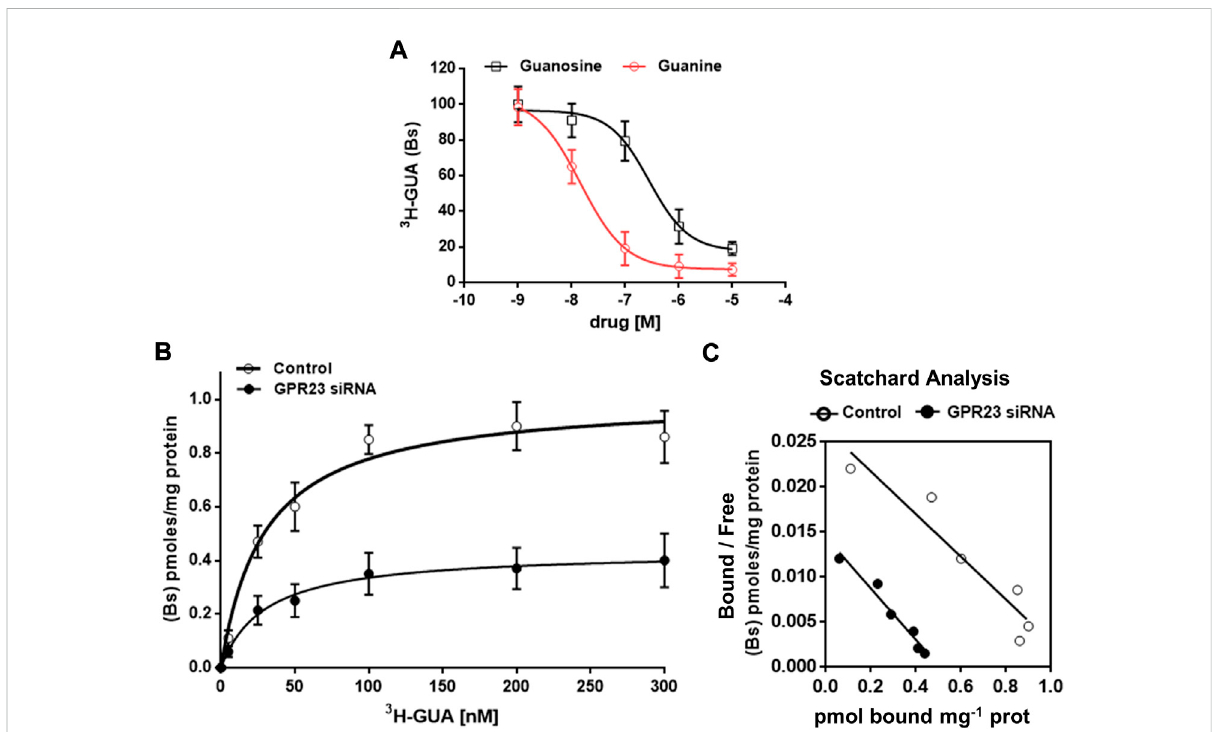
FIGURE 6 Characterization of [ 3 H]-GUA radioligand binding to U87 cells membrane extracts. In all experiments membrane extracts were incubated with the indicated drugs under standard assay conditions, i.e., 30 min incubation time, 25 ° C temperature, pH 7.4). (A) Displacement of 50 nM [ 3 H]-GUA binding from U87 cell membrane (50 μ g protein) by unlabeled GUA or guanosine (GUO) (both at concentrations in the range from 0.001 to 10 μ M). The values are the mean ± SD of three independent experiments, each point in triplicate. Statistical signi fi cance (two-way ANOVA test): *** p < 0.001 GUO vs. GUA displacement curve. (B) Saturation binding of [ 3 H]-GUA at 25 ° C using control and GPR23 silenced U87 cell membranes (50 μ g protein), which were incubated with increasing concentrations (6.25 – 300 nM) of [ 3 H]-GUA under standard assay conditions. Non-speci fi c binding was de fi ned in the presence of 500 μ M GUA. Values are the means ± SD of four experiments, each point performed in triplicate. Data in the Panel (A,B) were fi tted by a computerized nonlinear regression analysis and resolved with a one site model. (C) Scatchard analysis of the data shown in (B) . For the panels B and C, Bs, bound speci fi c; statistical signi fi cance (two-way ANOVA test): *** p < 0.001 vs.